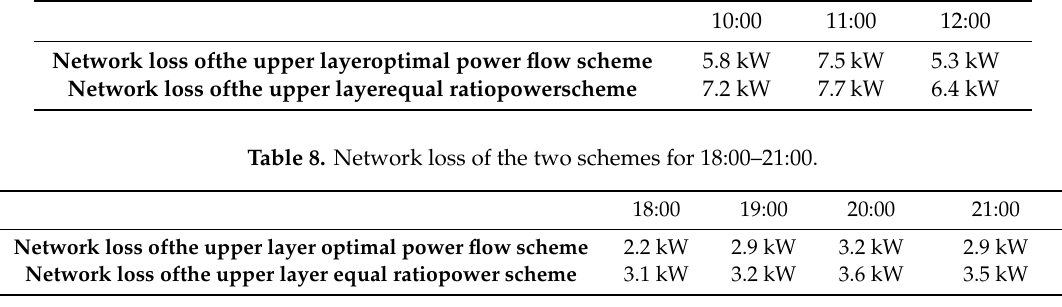
Table 7. Network loss of the two schemes for 10:00–12:00.